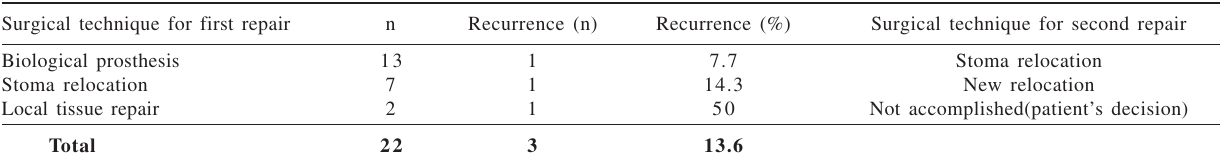
Table 2 – Surgical technique for primary repair of paracolostomy hernia, recurrence rate, and surgical technique used for second